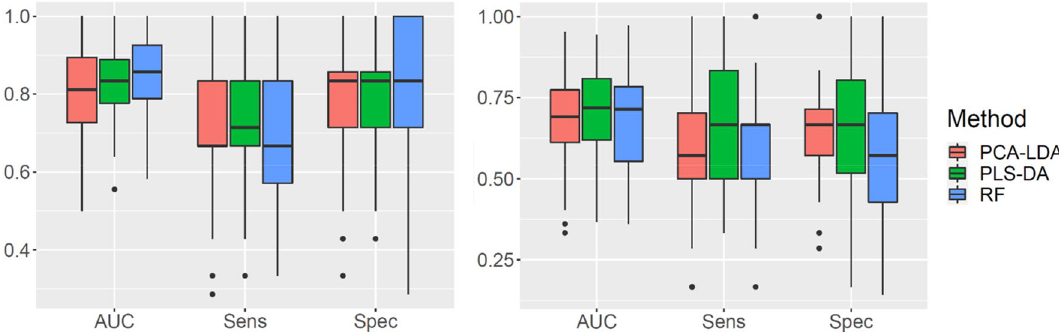
Figure 3. Boxplot of the area under the curve (AUC), sensitivity (Sens) and specificity (Spec) for the repeated k -fold cross-validation data, referred to the second derivative spectra in the two spectral regions: 1800–900 cm −1 (left panel) and 3050–2800 cm −1 (right panel). Box stretches from lower hinge (first quartiles Q1) to upper hinge (third quartiles Q3). Median is shown as a line across each box. The outliers, defined as values lower that Q1 − 1.5*IQR or upper than Q3 + 1.5*IQR, where IQR is the interquartile range, are shown as black dots. Vertical solid lines (whiskers) show the lower and upper values, excluding outliers.